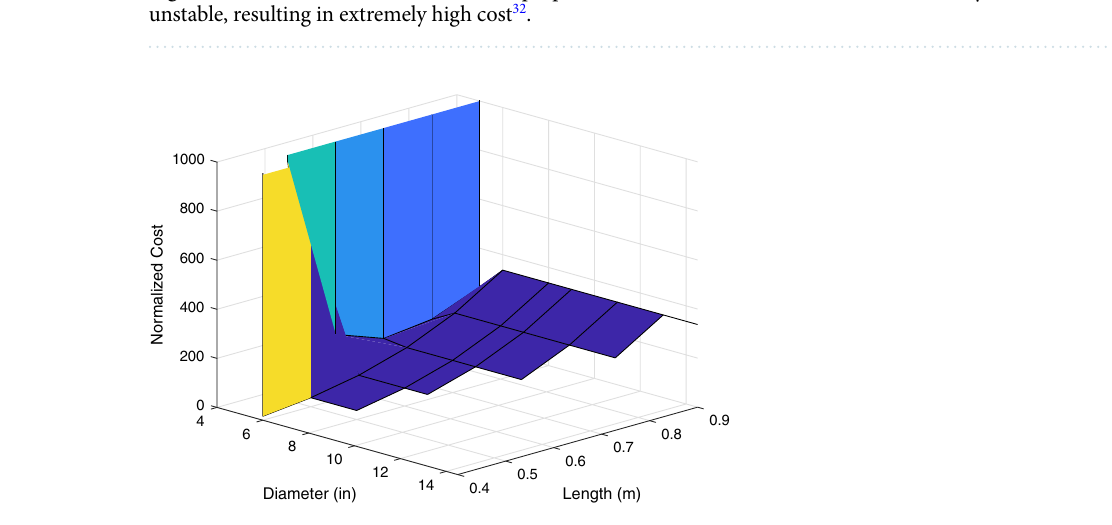
Figure 6. Behavior of the surface for parameters that result in a stable system: this view allows us to pick viable combinations of parameters that will have the best performance 32